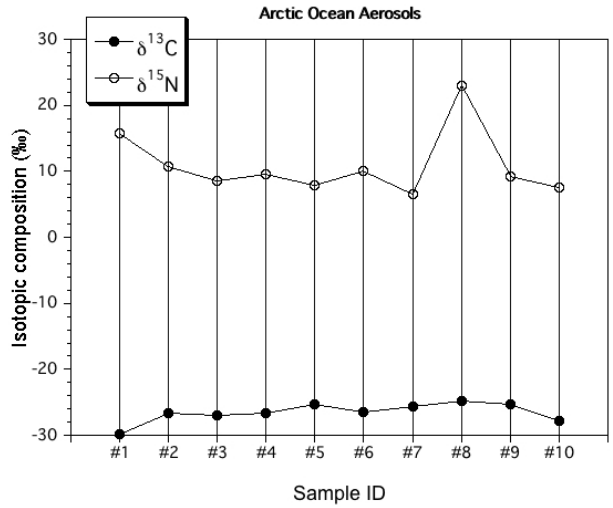
Fig. 3. Stable carbon isotopic compositions ( δ 13 C) of total carbon and nitrogen isotopic compositions ( δ 15 N) of total nitrogen (TN) in the marine aerosols from the western Arctic